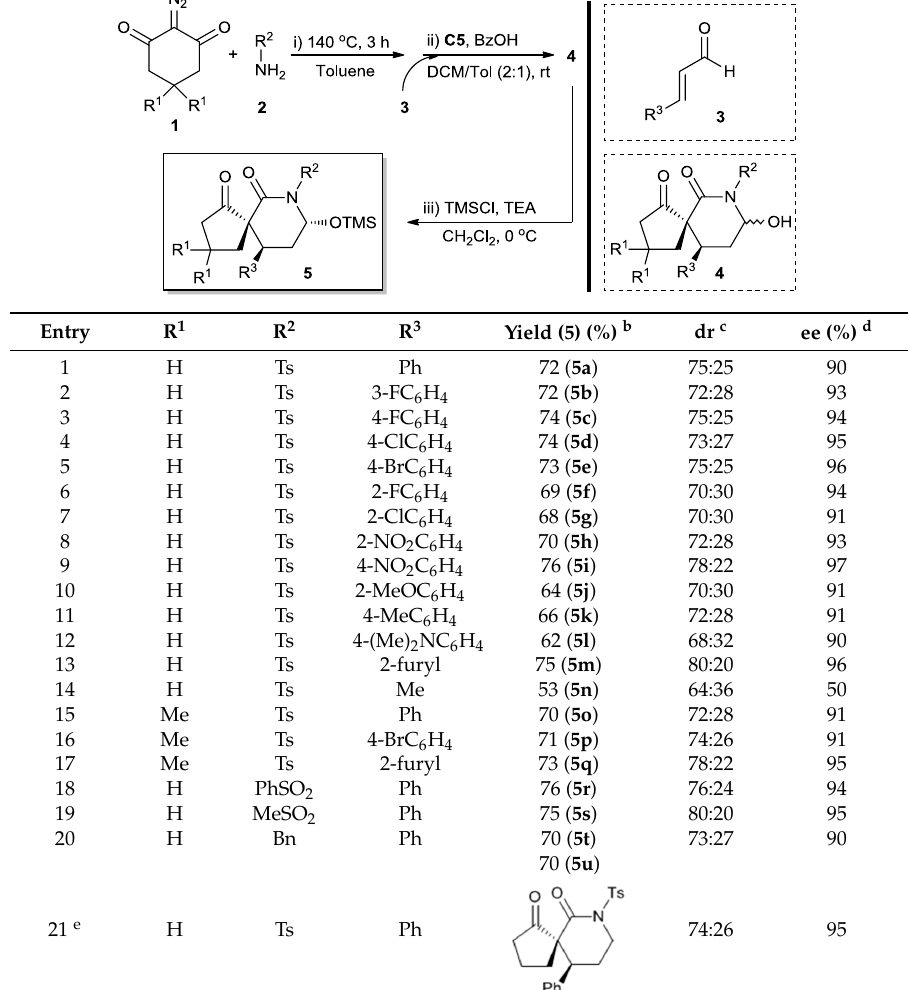
Table 2. Investigation of the scope of the tandem reaction using the optimized conditions a . 108